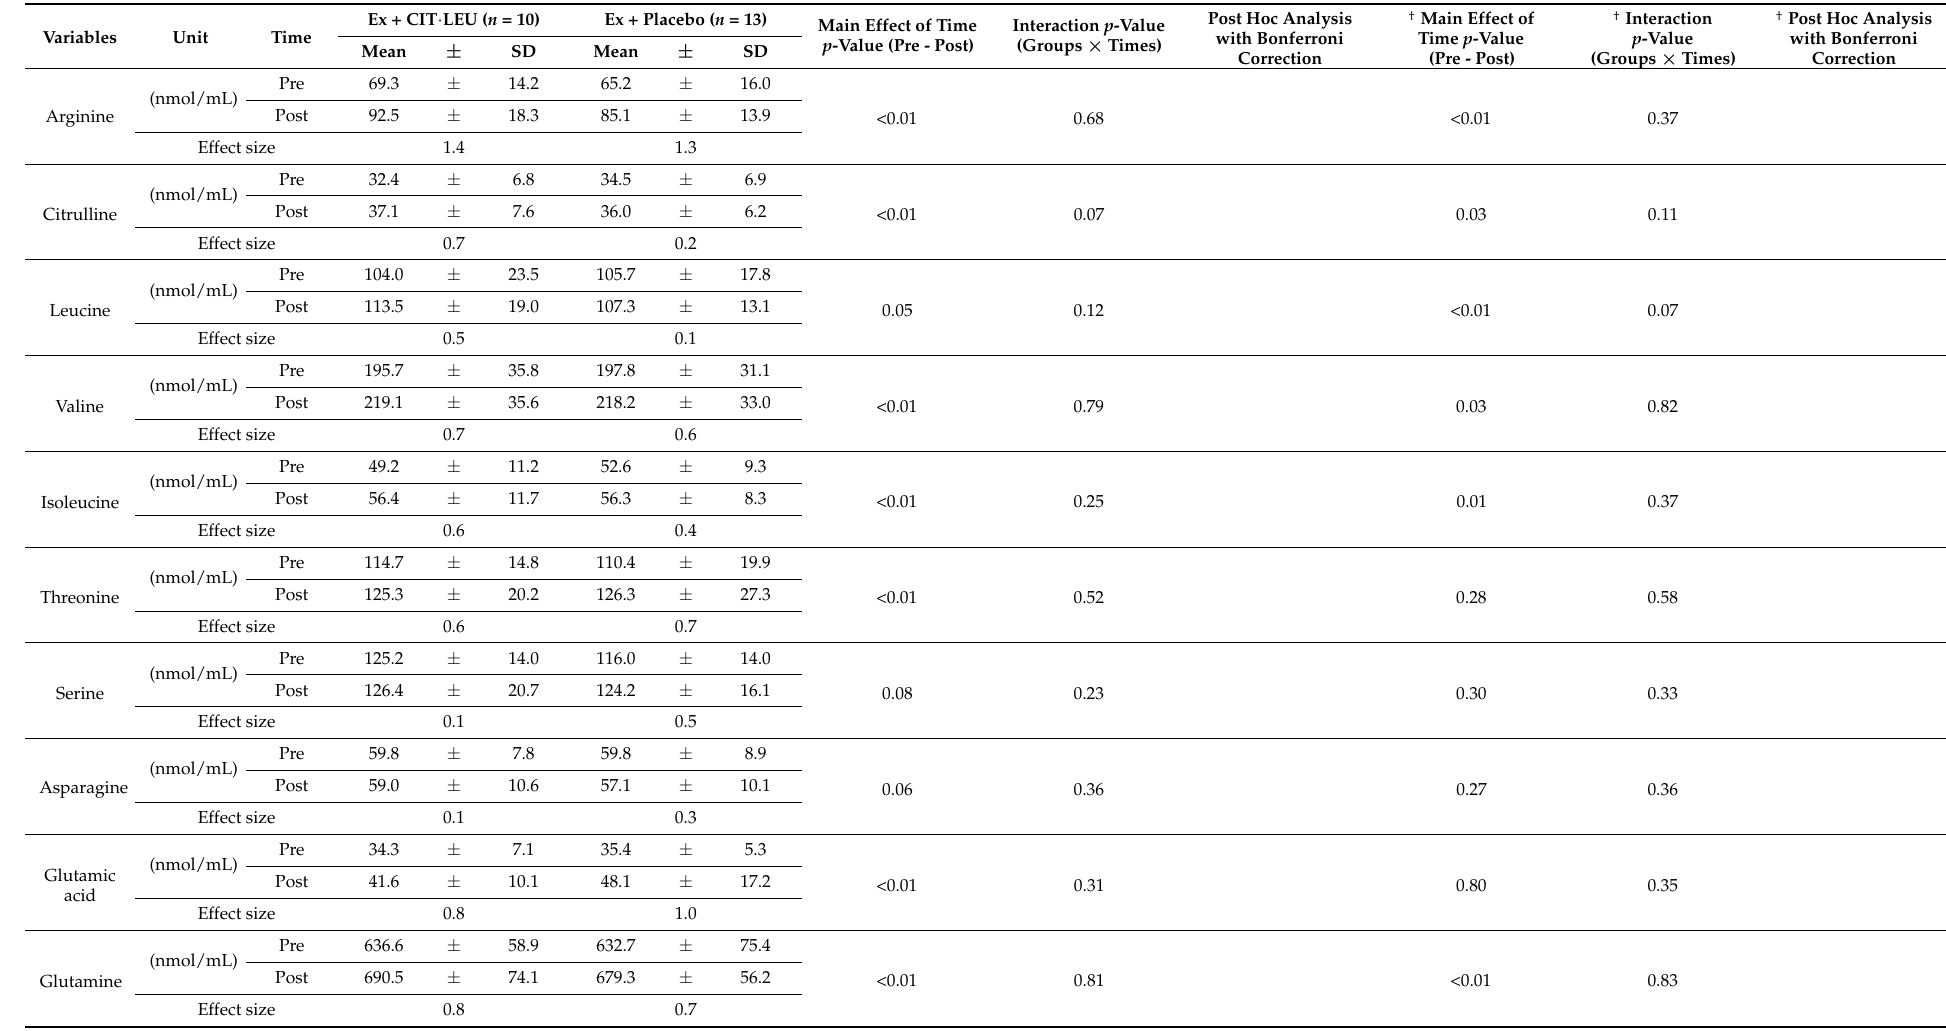
Table 5. Effects of amino acids (CIT and LEU) intake and multicomponent exercises on amino acid